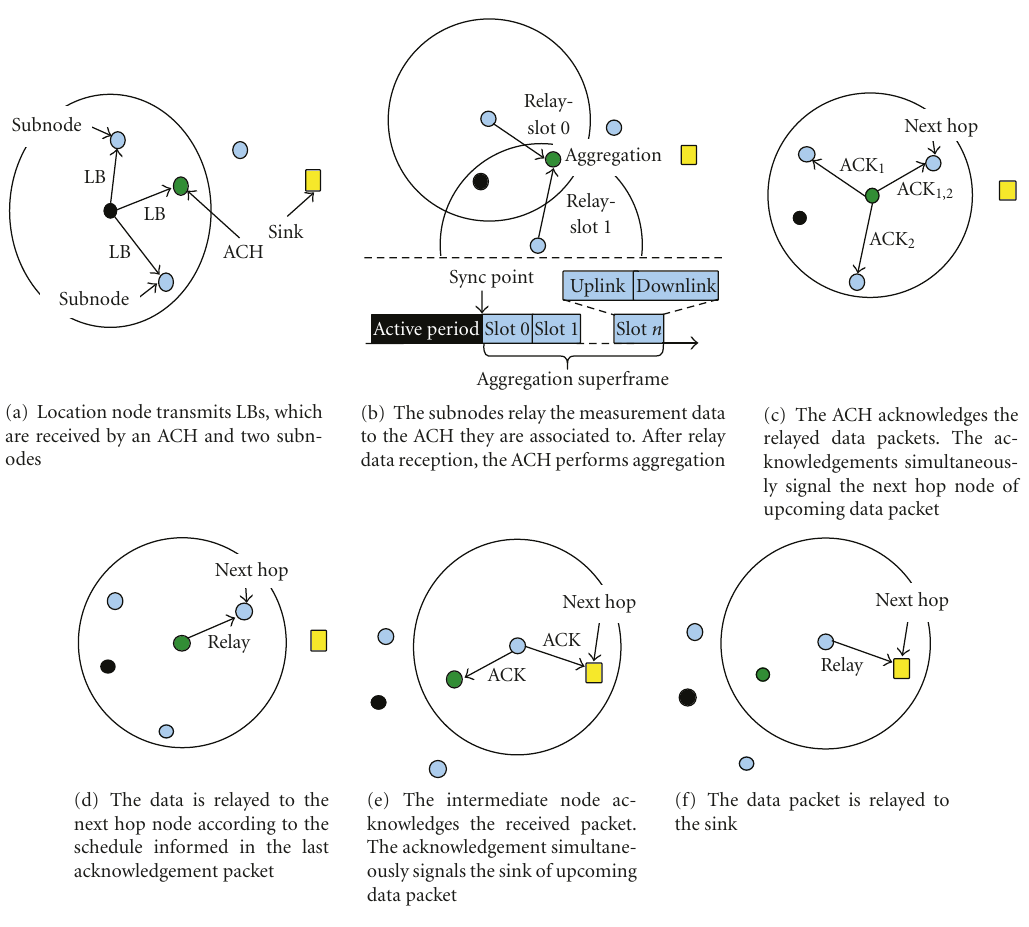
Figure 5: Localization data aggregation and relay via multiple hops to the